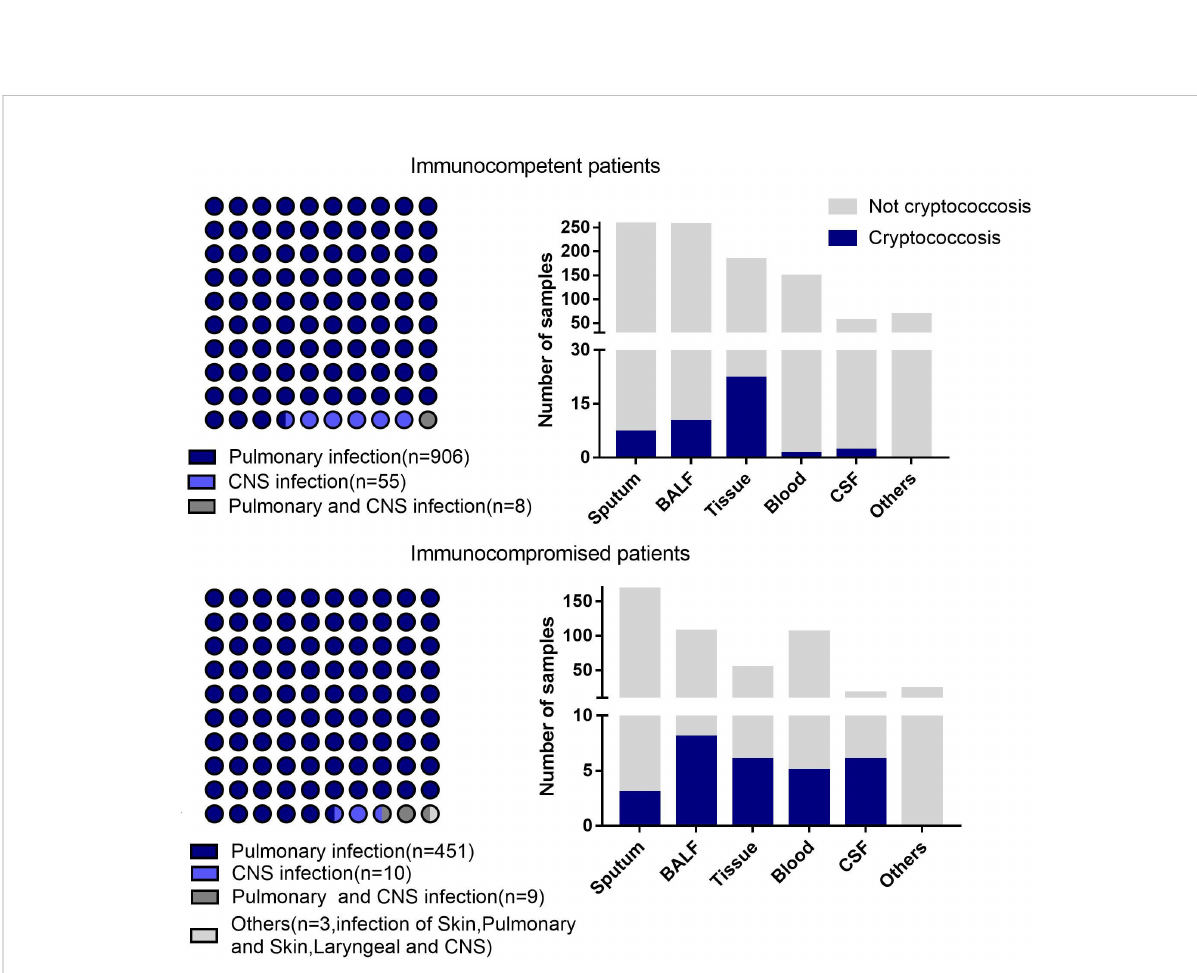
FIGURE 2 Disease distribution and different kinds of samples from the patients with different immune states. Others includes pleural